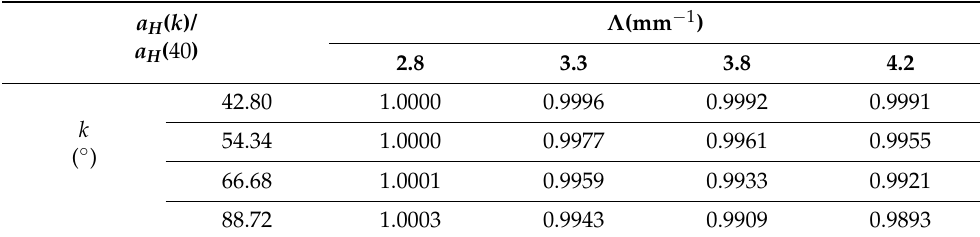
Table 3. The specific attenuation for a horizontally polarized link changes while the elevation angle increases from 40 degrees. Nonetheless, the maximum change is only about